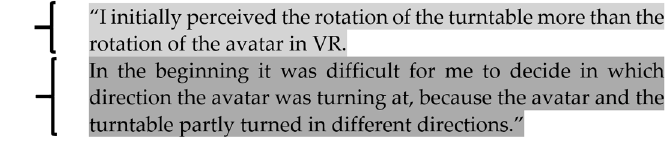
Figure 2. An example of the procedure of qualitative content analysis [34] regarding the students’ written answers during the feedback session. For this article, the responses of the students originating from Germany were translated into English and corresponding categories were also identified in English.